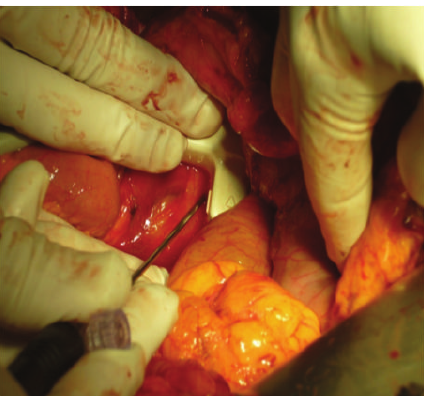
Figure 1: US-guided intraoperative application of RFA